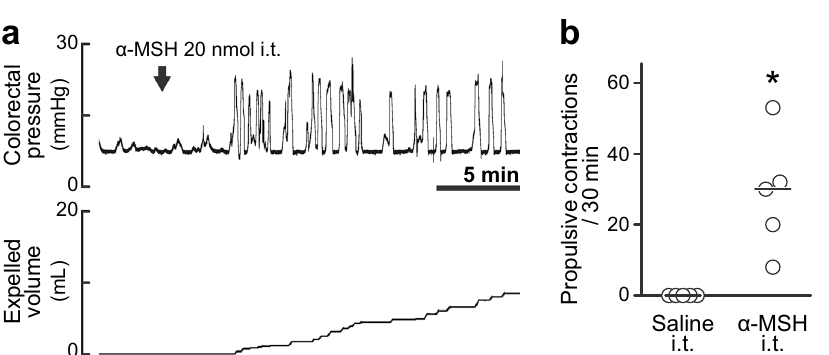
Saline α-MSH i.t. i.t.